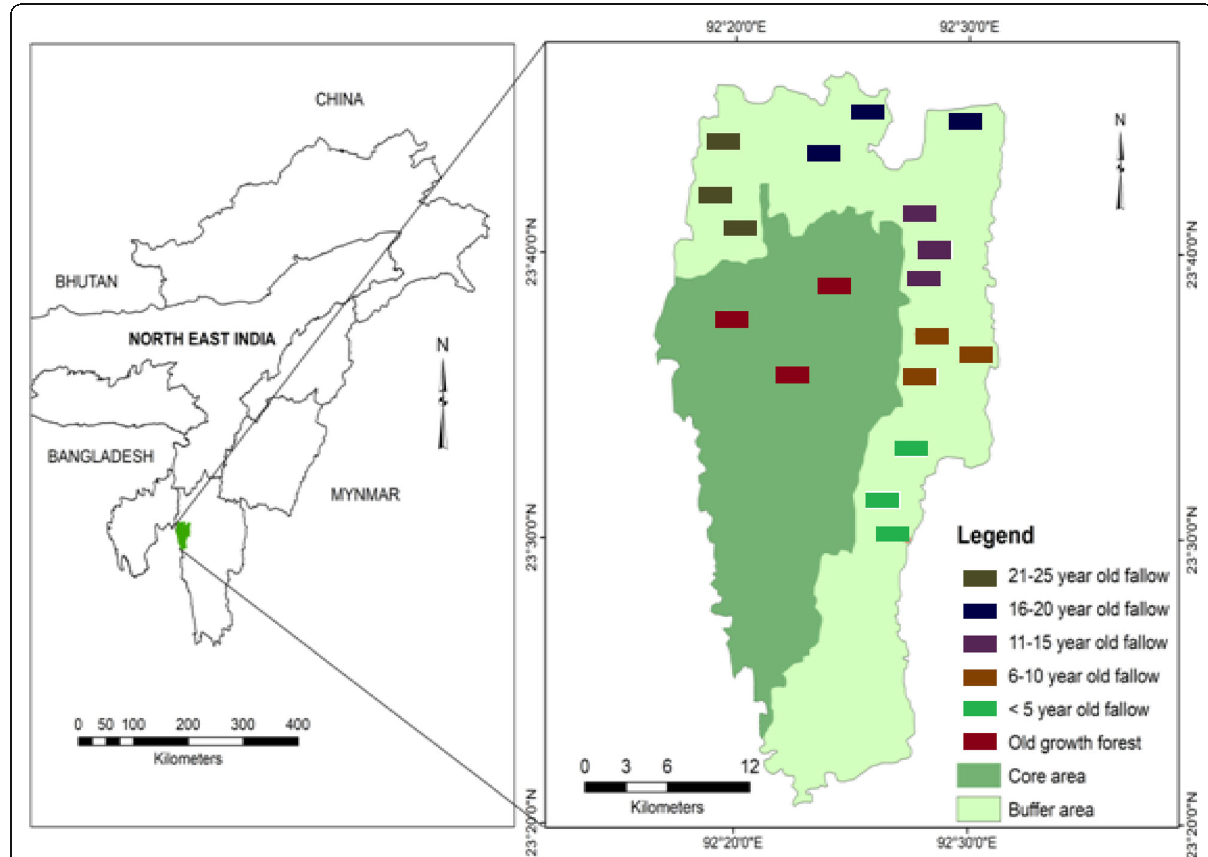
Fig. 1 Map of the study area showing locations of the old-growth forest plots in the core area and differently aged shifting cultivation fallows plots in the buffer